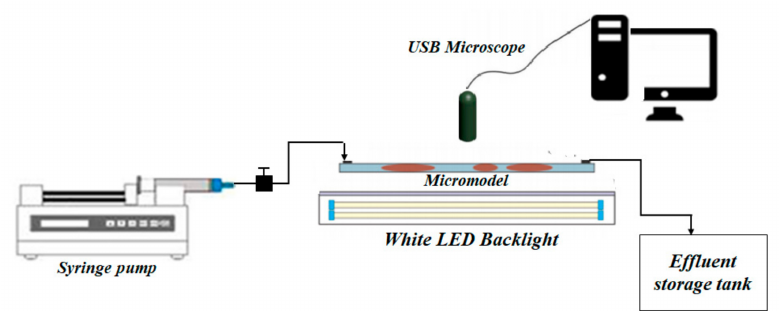
Figure 6. Schematic representation of fluid injection systems including a glass micromodel, a syringe pump for nanofluid and oil injection, USB digital microscope for continuous recording of images, a computer for data acquisition and a white LED backlight for diffusion light source to illuminate the micromodel.